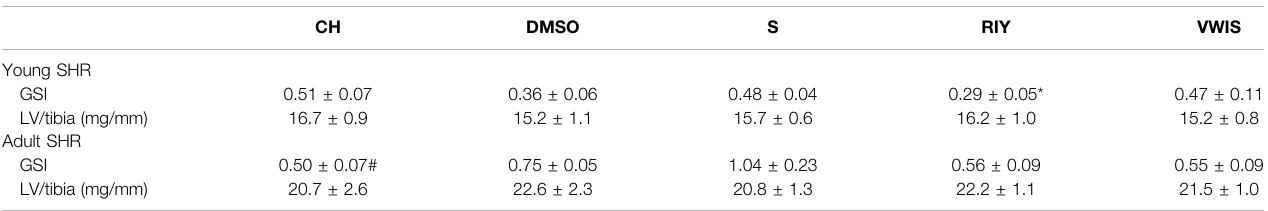
TABLE 2 | The glomerulosclerosis index (GSI) and left ventricular hypertrophy